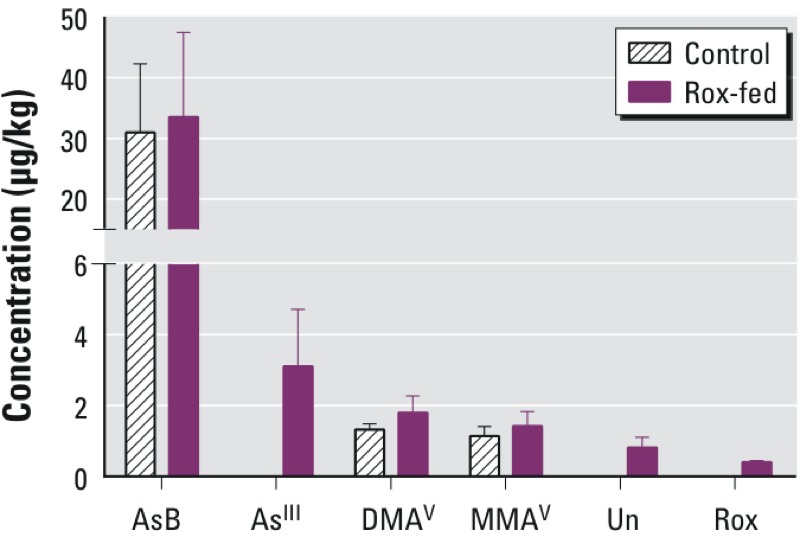
The mean concentrations of AsB, AsIII, DMAV, MMAV, Unknown arsenic species (Un), and Rox in eight control chickens and eight Rox-fed chickens on Day 35 (final day) of the feeding experiment. This was 7 days after the final feeding of Roxarsone on day 28. Error bars represent standard deviation from four replicate measurements of each of the eight chicken samples. The concentrations of AsIII, Rox, and Unknown are significantly higher (p < 0.01) in the Rox-fed chickens than in the control chickens. The concentrations of AsB are not significantly different (p > 0.01) between the control and the Rox-fed chickens.